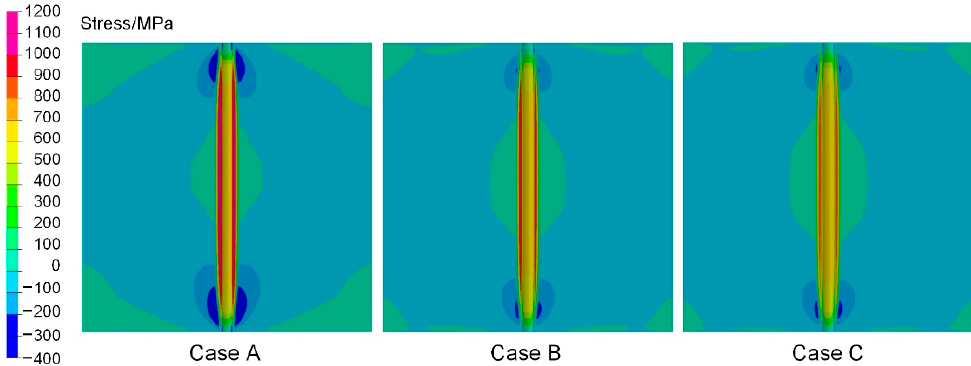
Figure 15. Longitudinal residual stresses distributions on upper surfaces.